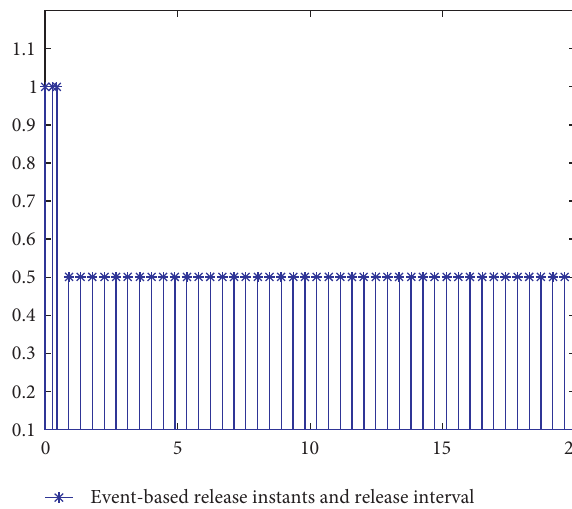
Figure 9: The dynamics of event-triggered mechanism. ( t ) and e ( t ) . 1 2 Table 2: Amount of date communication under varying ℓ , η , and ρ